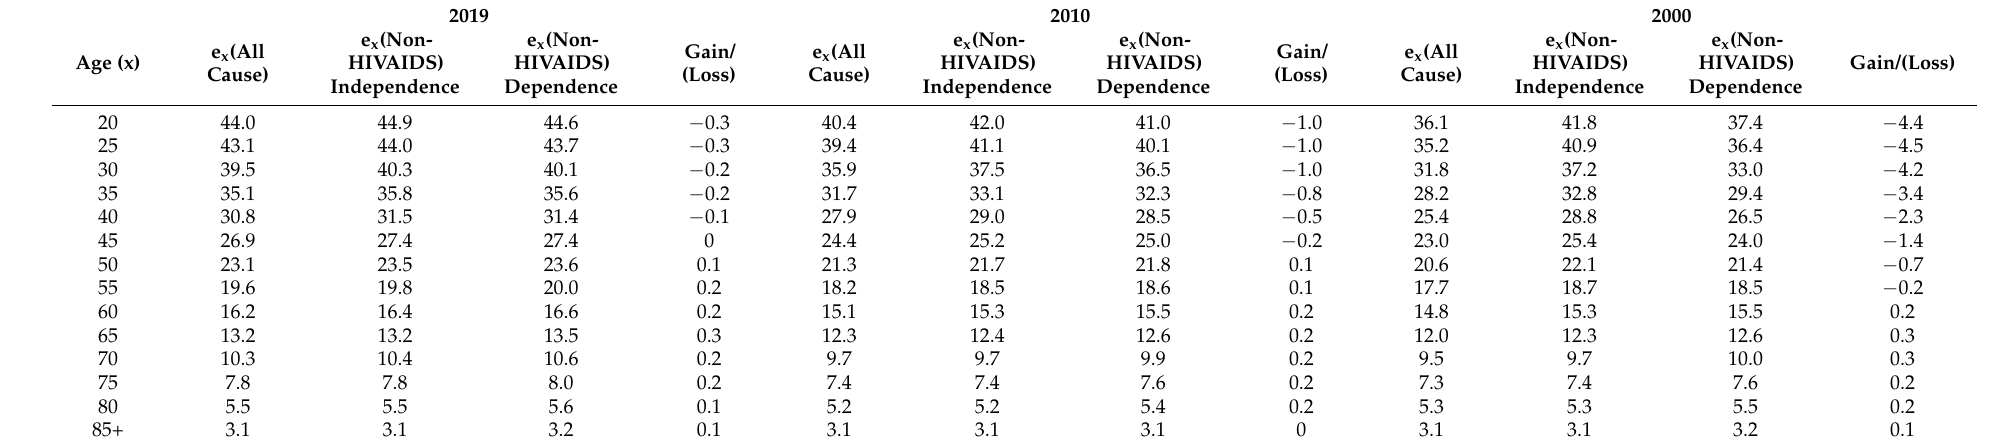
Table 6. Life expectancy gain/loss analysis for males.